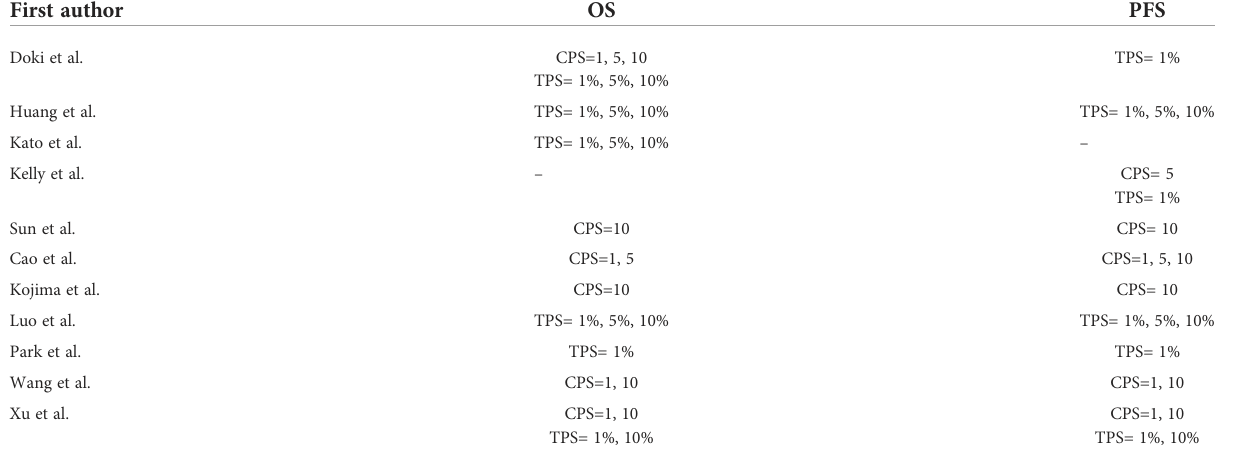
TABLE 2 PD-L1 cut-off values employed by included studies.